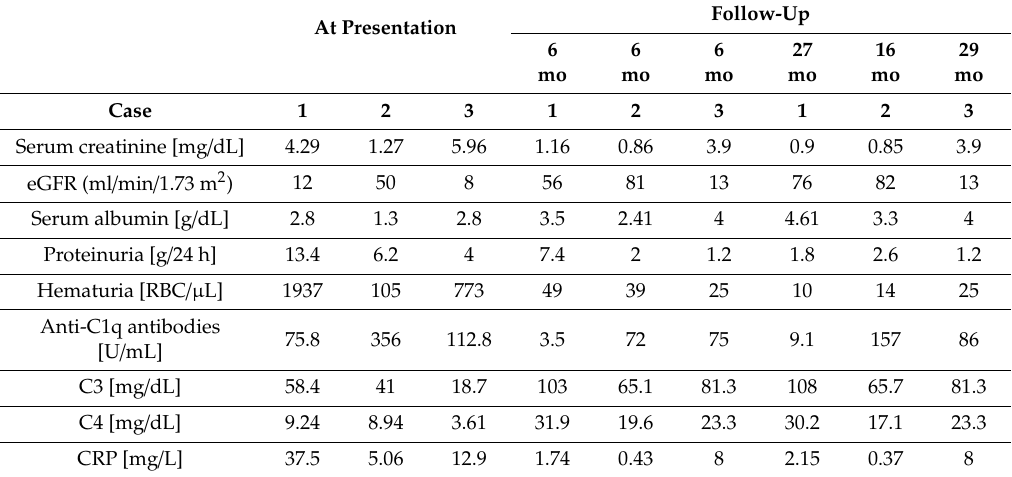
Table 1. Laboratory data in reported